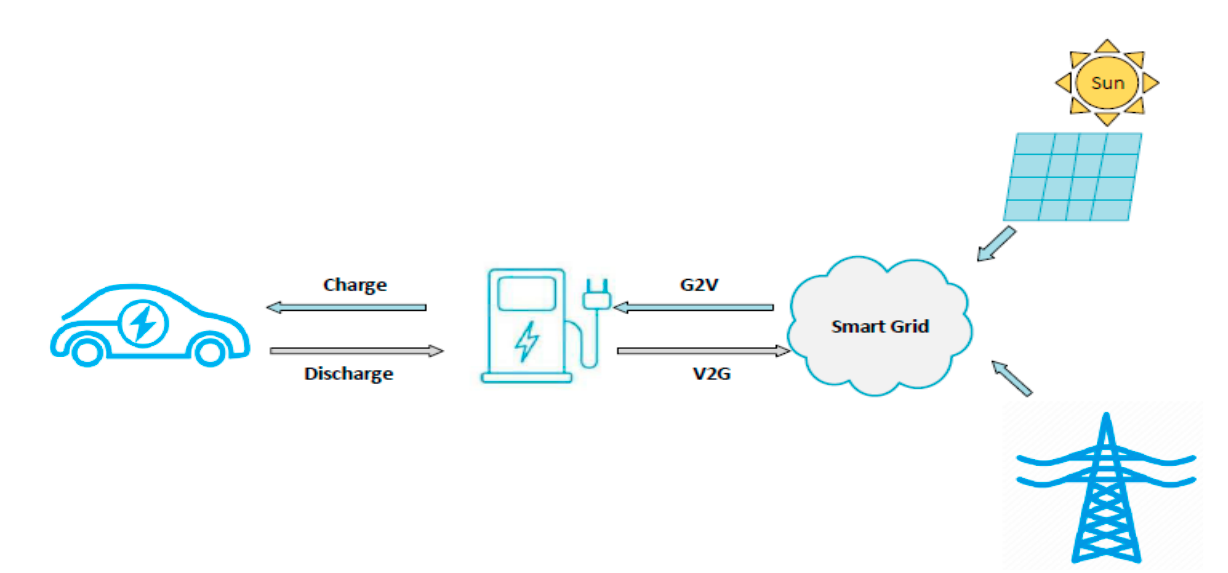
Figure 10. Figure Car connection to the network and vice versa.